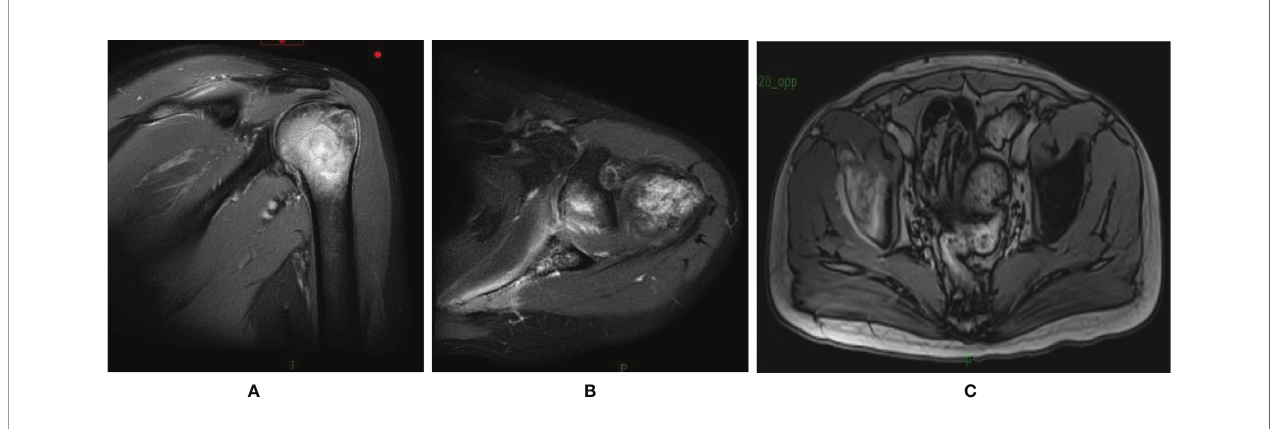
FIGURE 2 | MRI of the shoulder joint and elvic showed newly formed bone metastases in the left humeral (A, B) and the right iliac